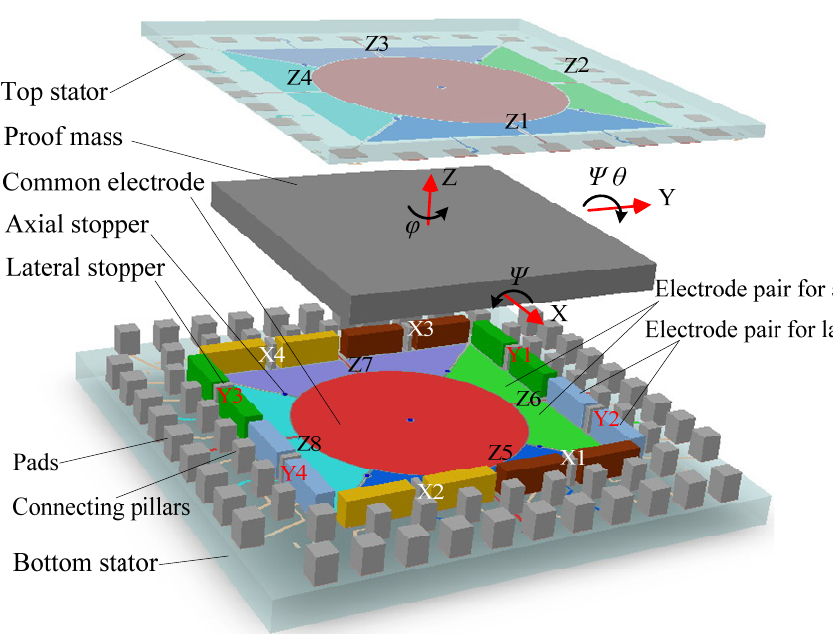
Figure 1. The exploded view of the microaccelerometer